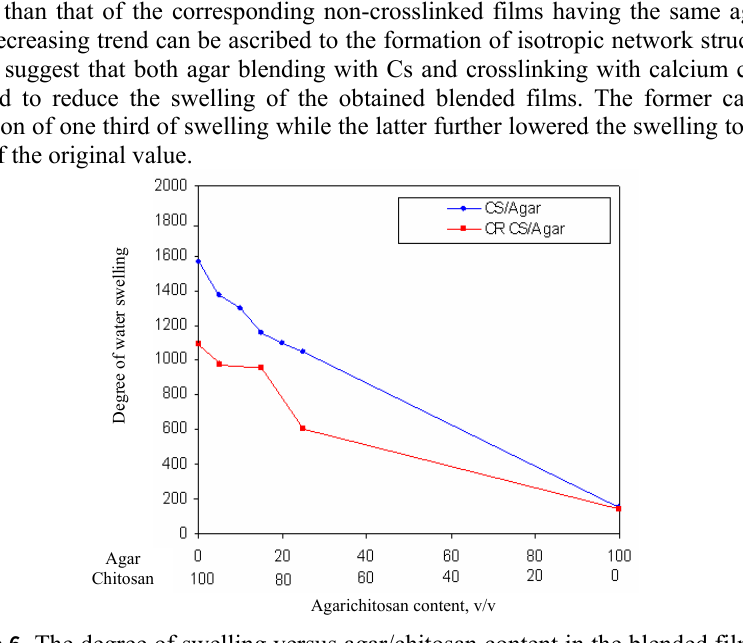
Figure 6. The degree of swelling versus agar/chitosan content in the blended films and their crosslinked